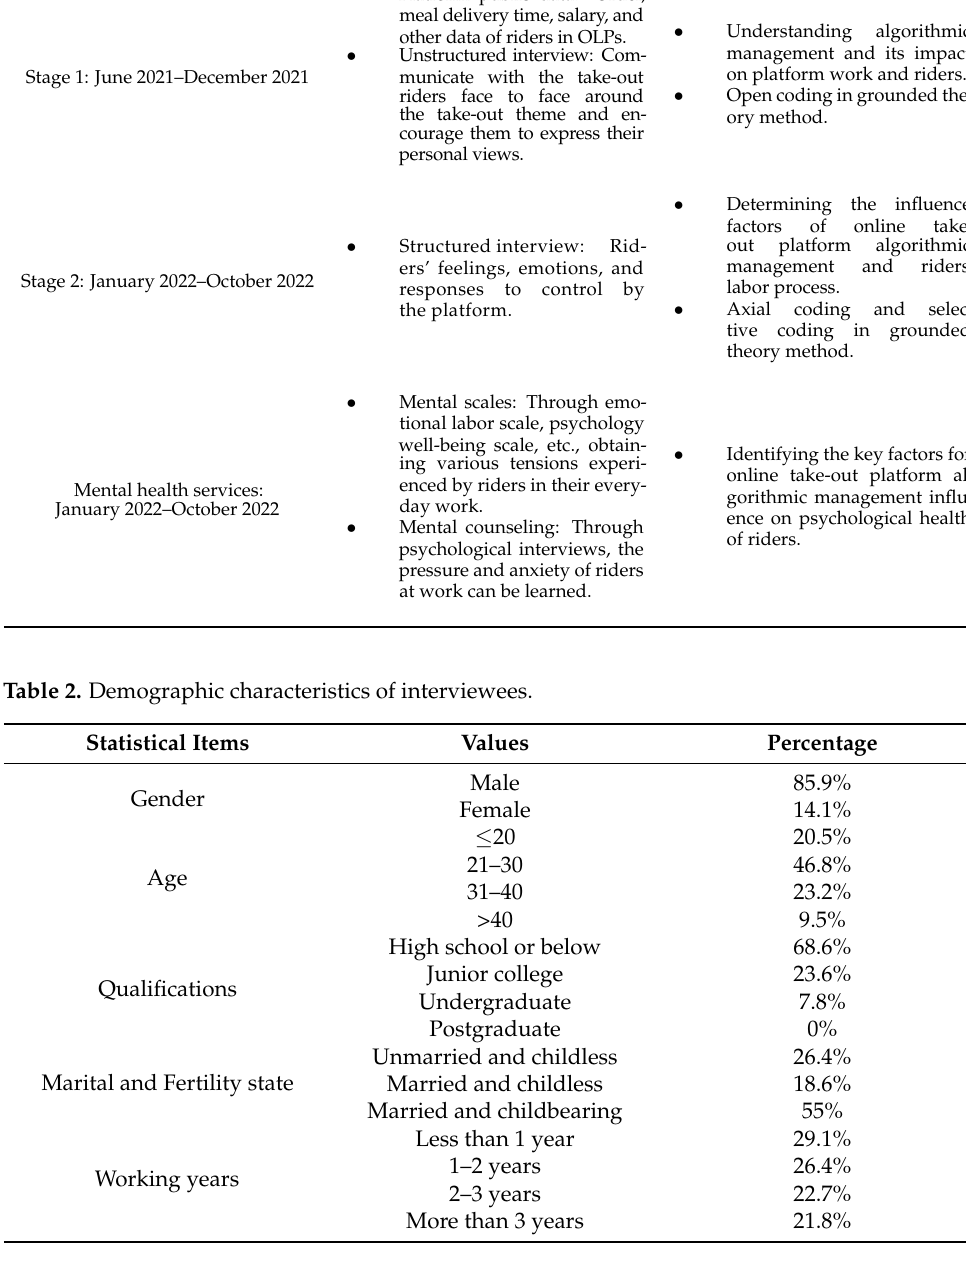
Table 3. Job characteristics of